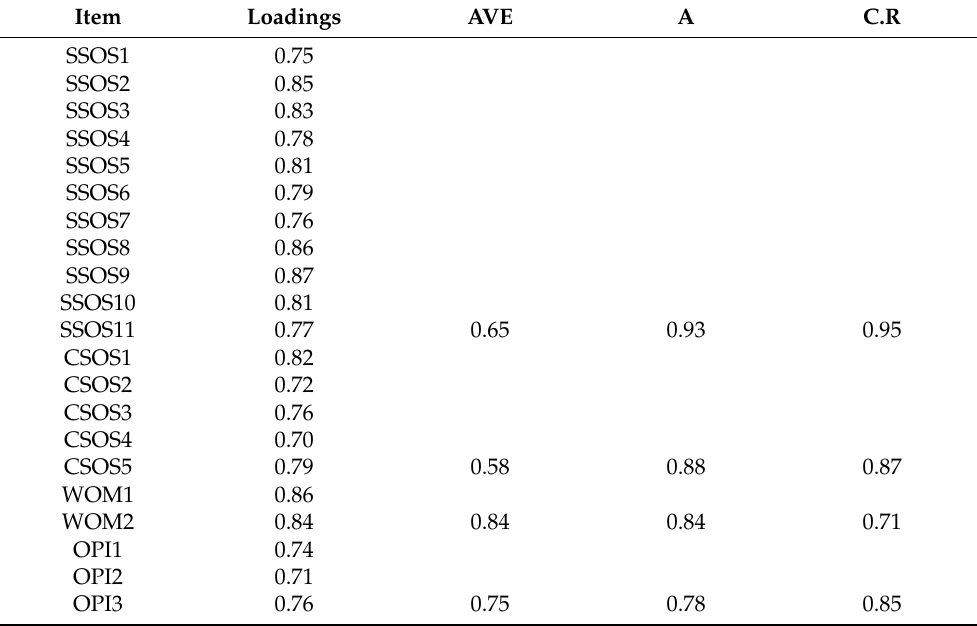
Table 2. Factor loading, convergent validity, and reliability